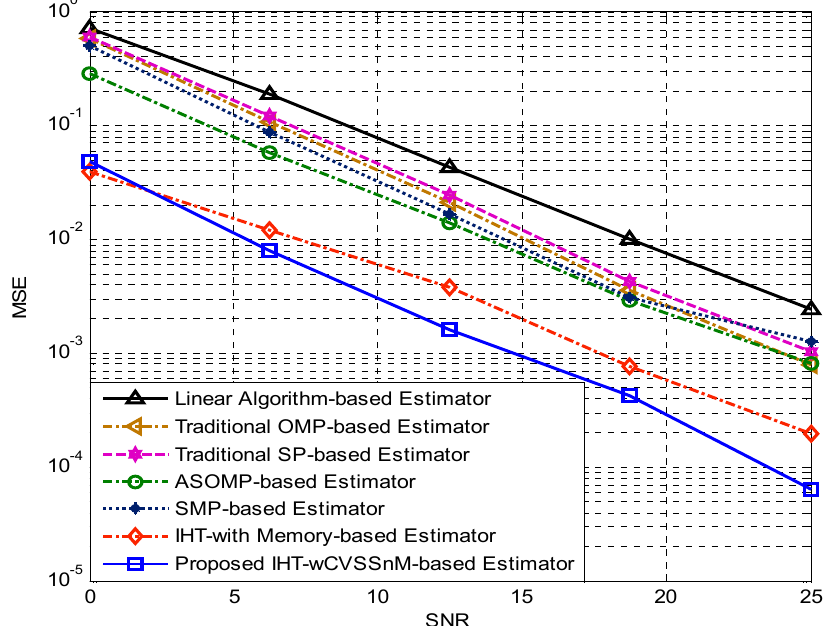
Figure 2. Achievable comparative MSE versus signal to noise ratio (SNR) performance of the proposed IHT-wCVSSnM-based estimator with other channel estimators when the degree of temporal correlation is set as 𝐿 = 8 .